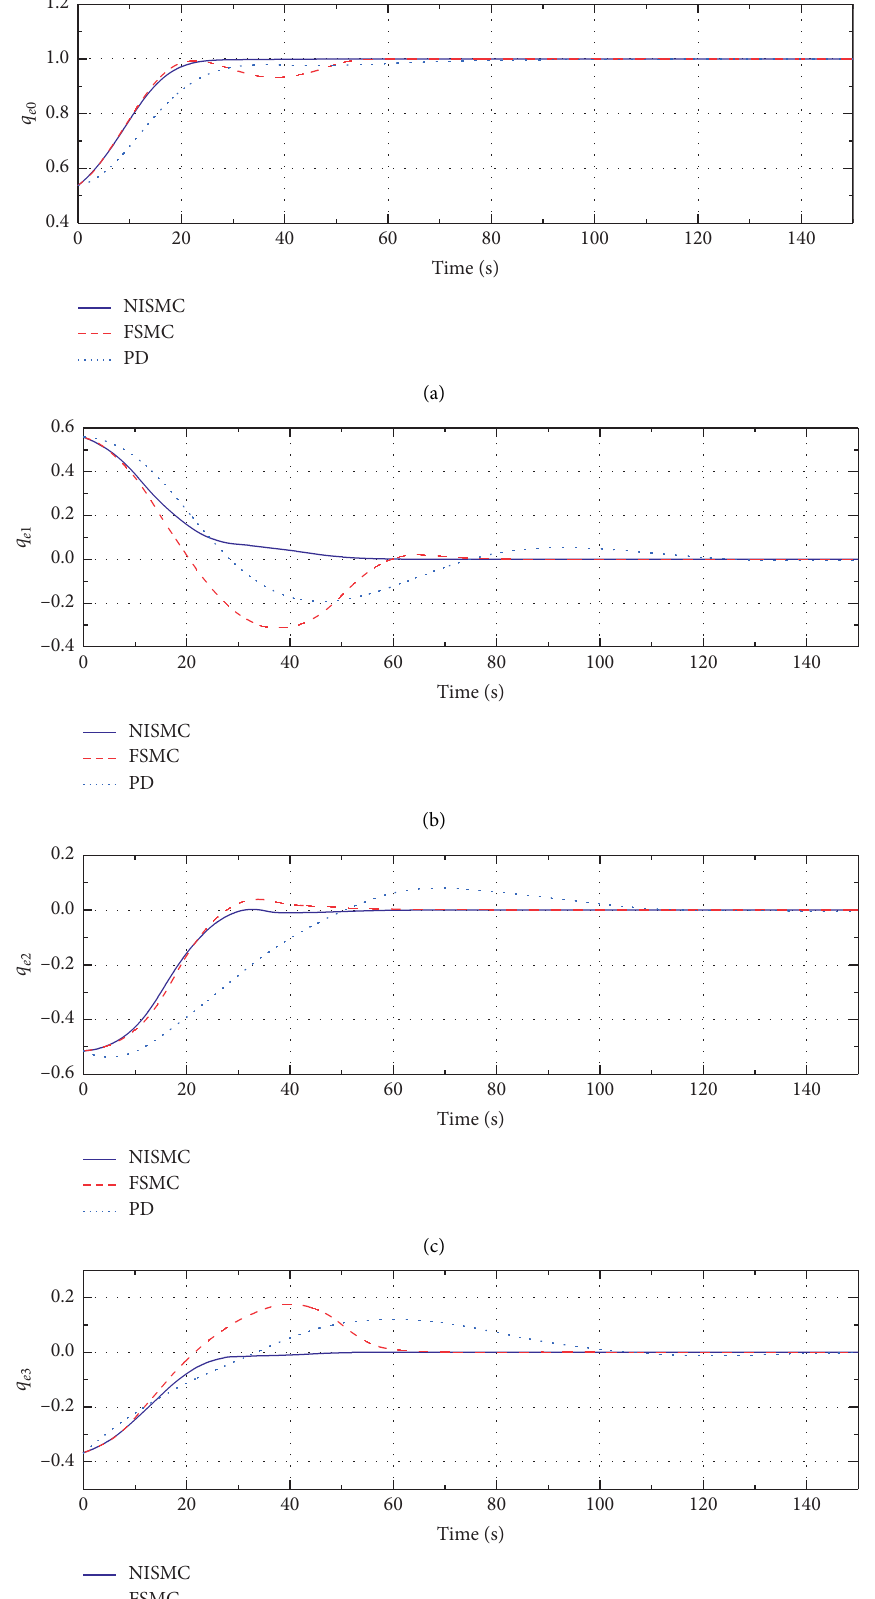
Figure 8: Comparison of platform error